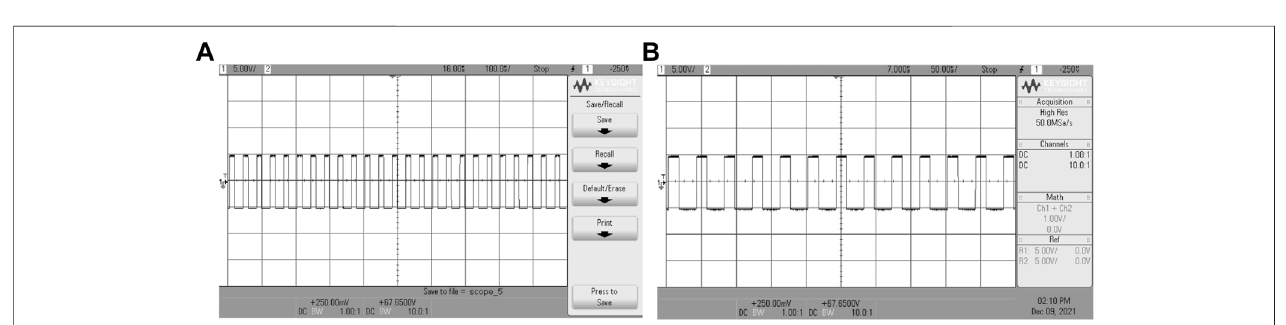
FIGURE 11 | Simulated input pulse to the TPC.